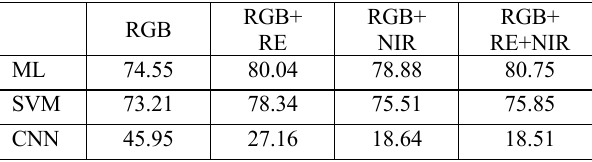
Table 4. Overall accuracy performance of contribution of spectral predictors (RGB, RGB+RE, RGB+NIR, Figure 8. Support vector machine classification from the Gram- RGB+RE+NIR) with maximum likelihood (ML), support vector Schmidt pansharpening. machine (SVM) and convolutional neural network (CNN) classifiers.